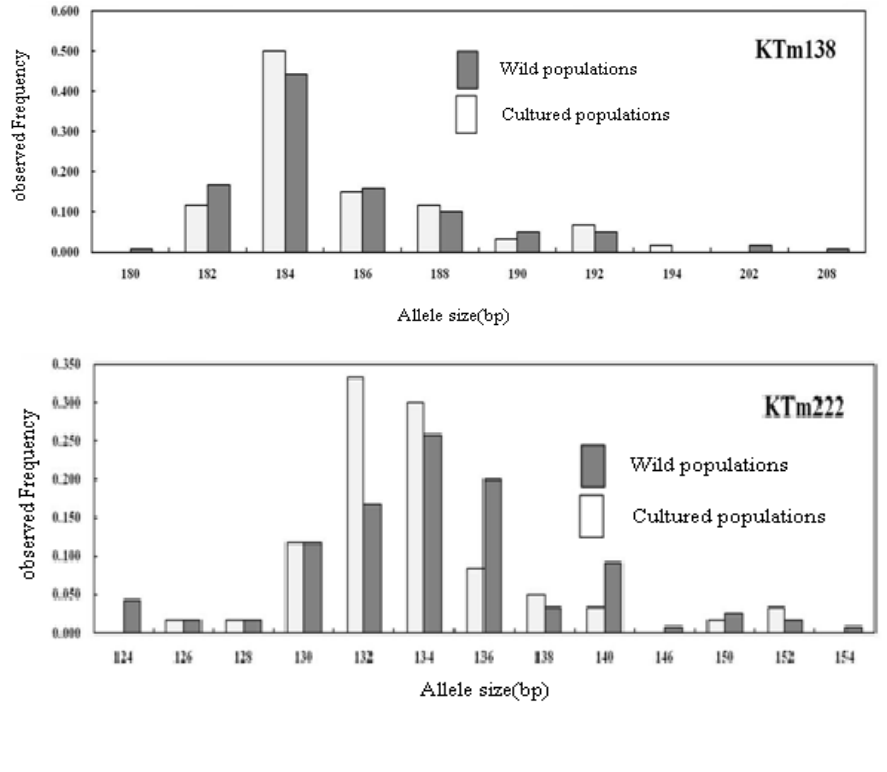
Figure 1. Allele size frequency distributions of the 20 microsatellite loci of Thamnaconus modestus used in this